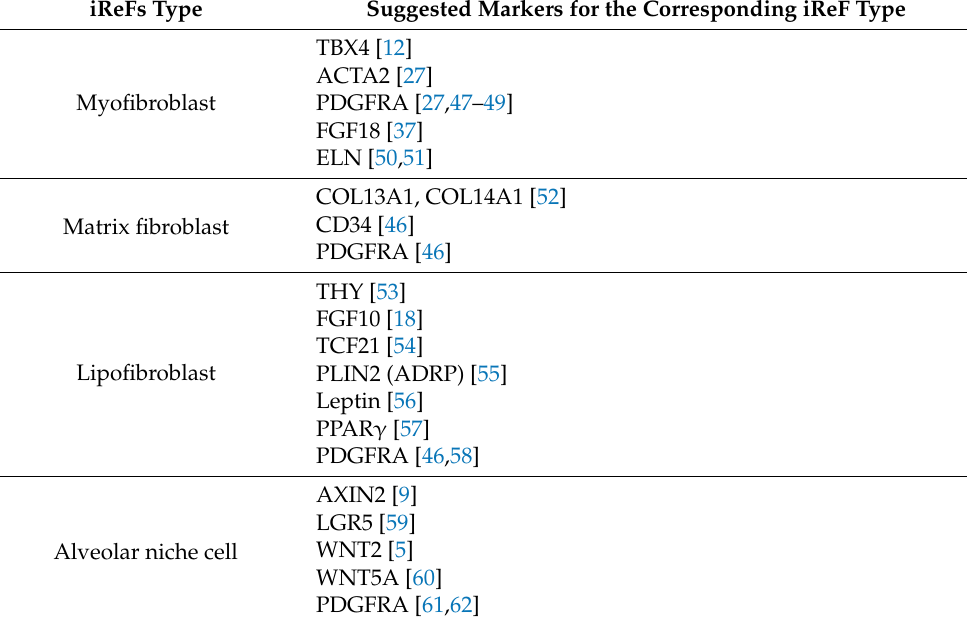
Table 1. Commonly used markers to distinguish different populations of iReFs during the alveolar- ization phase and perialveolarization